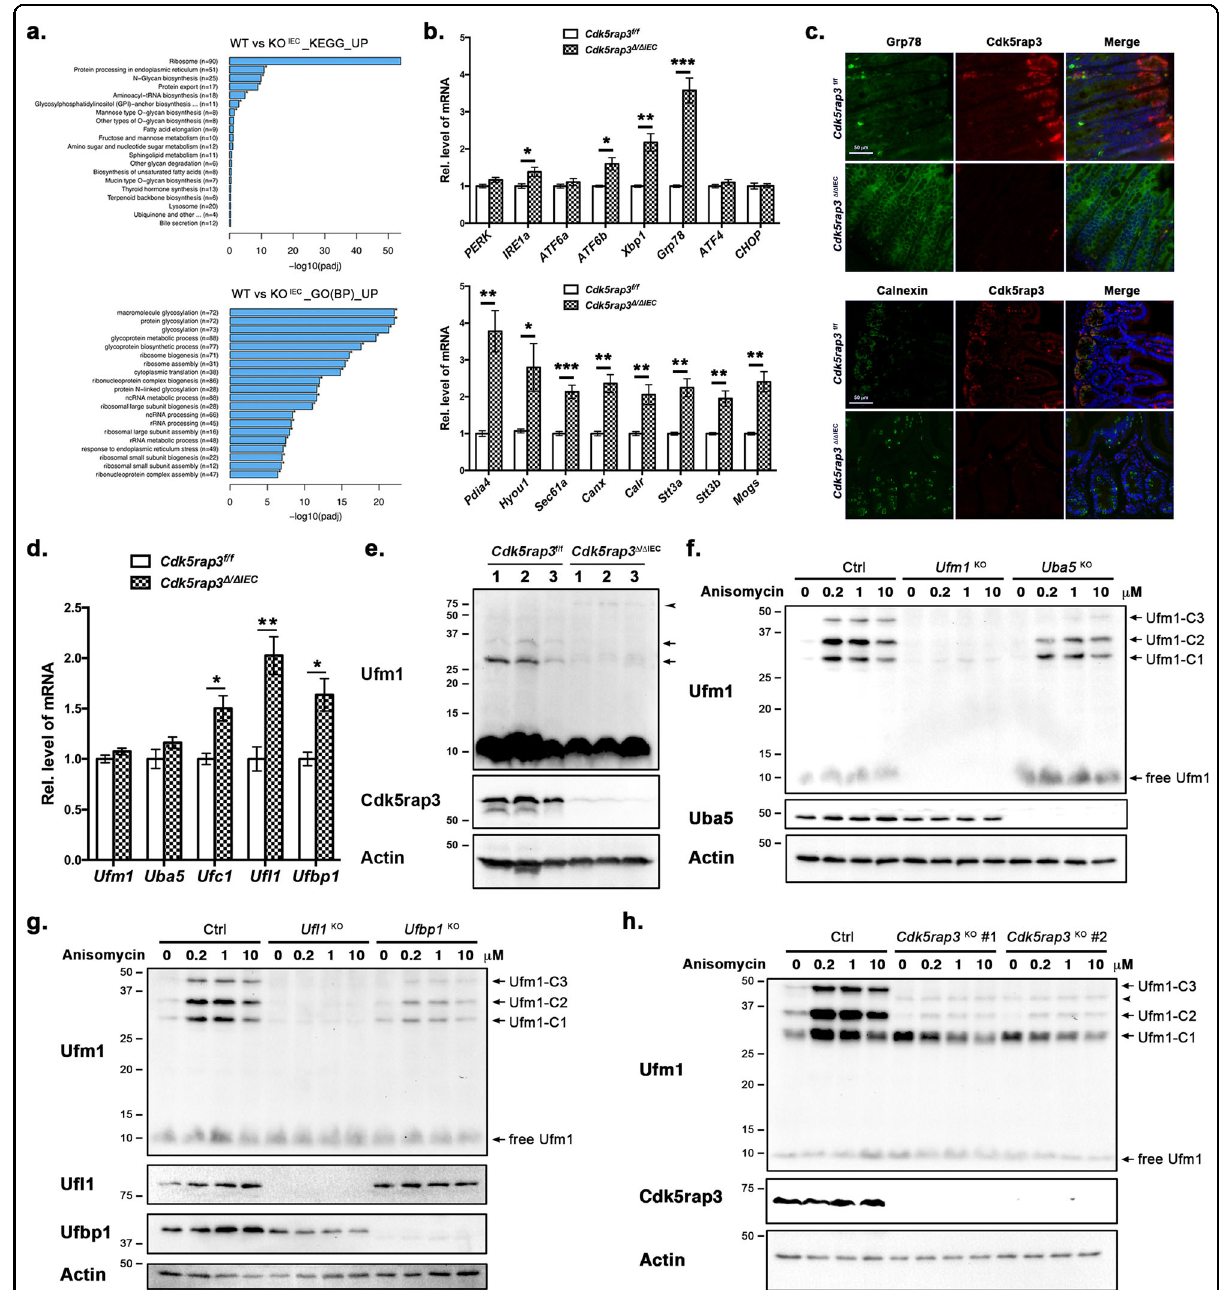
Fig. 5 Cdk5rap3 knockout results in defective ufmylation pathway and activation of Unfolded Protein Response (UPR). a GO and KEGG enrichment analysis of up-regulated DEGs in Cdkrap3 Δ / Δ IEC intestine. b Quantitative RT-PCR con fi rmation of up-regulated genes that are involved in UPR and ER-related protein glycosylation and folding. * p < 0.05, * * p < 0.01, *** p < 0.001 ( n = 4 mice per genotype). c Immuno fl uorescence staining of Grp78/Bip and Calnexin in ileal section of wild-type and Cdkrap3 Δ / Δ IEC mice. d Up-regulation of the components of the Ufm1 conjugation system induced by Cdk5rap3 knockout. Total RNA was isolated from small intestinal scrapes. * p < 0.05, * * p < 0.01 ( n = 4 mice per genotype). e The Ufm1 conjugates in wild-type and Cdk5rap3 KO IECs. Cell lysates of isolated crypts were subjected to immunoblotting of Ufm1. Endogenous of Ufm1 conjugates in wild-type cells were marked by arrows, while a new Ufm1 conjugate in Cdk5rap3 KO cells was indicated by an arrowhead. f UFMylation in wild-type, Ufm1 KO and Uba5 KO 293 T cells in the absence and presence of anisomycin. Cells were treated with anisomycin for 1 h. Ufm1-C1, 2, 3 are endogenous Ufm1 conjugates. g UFMylation in wild-type, U fl 1 KO and Ufbp1 KO 293T cells with and without anisomycin. h UFMylation in wild-type and Cdk5rap3 KO 293T cells with and without anisomycin. A new Ufm1 conjugate in Cdk5rap3 KO cells was indicated by an arrowhead (around 45